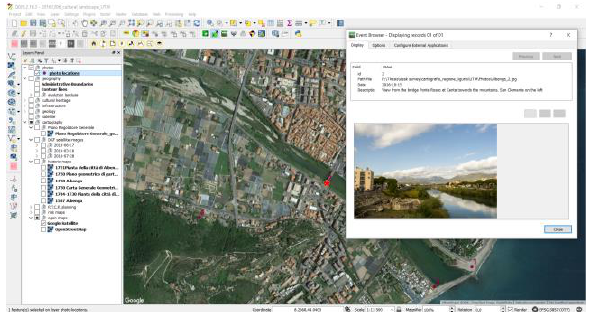
Figure 9. Inventory card of San Clemente, one of the assessed cultural heritage sites